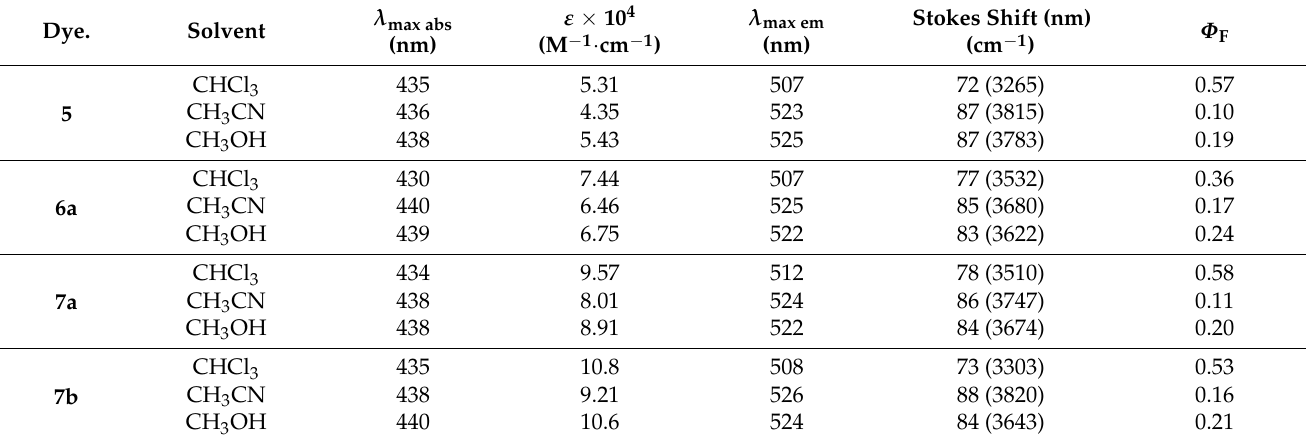
Table 2. Photophysical properties ( λ max abs , λ max em , ε , Stokes shift, and Φ F ) of aminopyronin 5 , 6a , 7a , 7b in chloroform, acetonitrile, and methanol at 25 ◦ C.